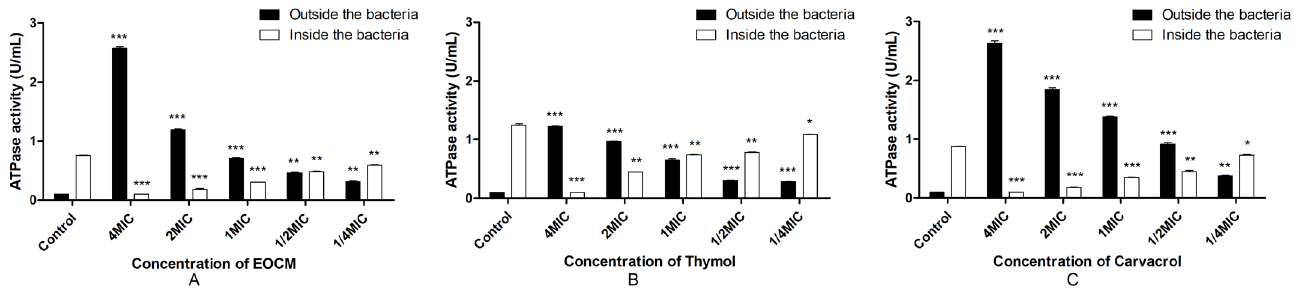
Figure 5. ATPase activity from S. aureus treatment with EOCM ( A ), thymol ( B ) and carvacrol ( C ). Error bars represent the standard deviations (SD) of the means from three biological replicates ( n = 3) in an individual experiment. ***, results were significantly different from those of control by a t test ( p < 0.001). **, results were significantly different from those of control by a t test ( p < 0.01). *, results were significantly different from those of control by a t test ( p < 0.05).